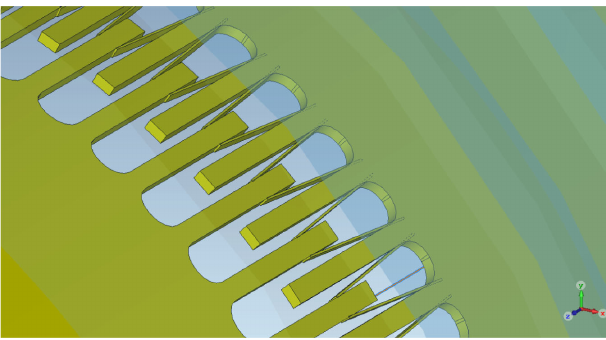
FIG. 18. Inside view of the rf shielding with small fingers between the teeth.